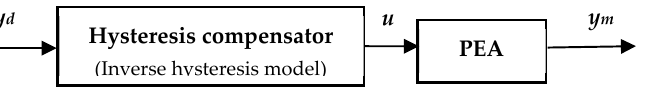
Figure 3. The application of the inverse hysteresis model in feedforward control, where y d and y m are the desired and measured trajectories of the PEA and u is the control input.